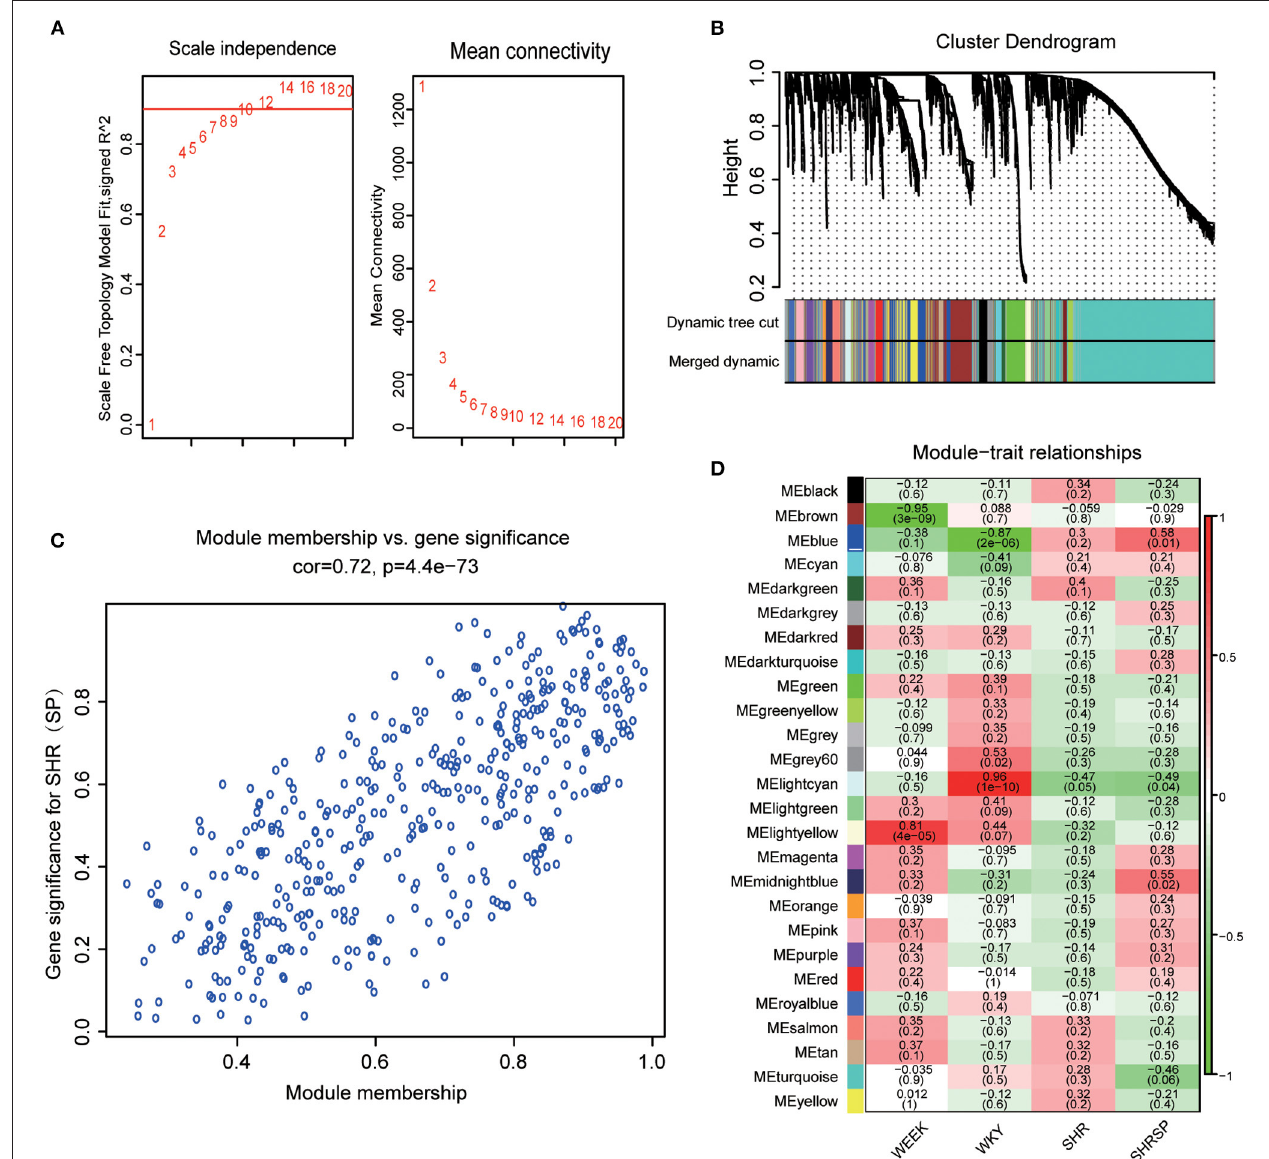
FIGURE 1 | Determination of the best soft threshold and module selection. (A) Through the scale independence and mean connectivity to choose the best soft threshold. The red words represent the soft threshold. (B) The tree clustering of genes and module form the cluster dendrogram; each color of the module represents a collection of genes with a similar expression. (C) Module membership and gene significance were analyzed. (D) The ordinate colors represent different modules, the abscissa represents different sample characters, the corresponding heat map shows its Pearson coefficient and probability, and the heat map color represents the correlation (the highest in red and the lowest in